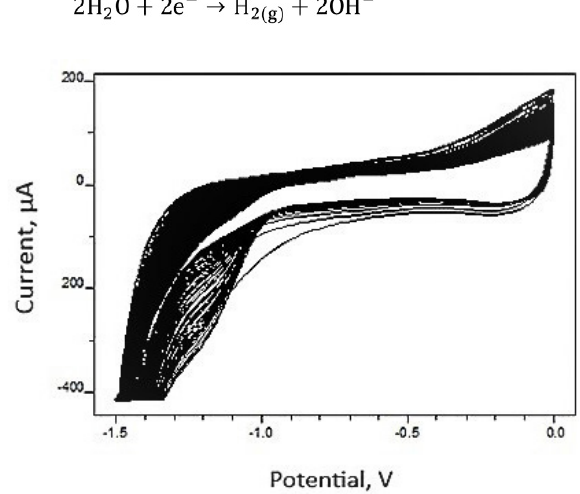
Figure 3. CV of electrochemical reduction of 1.0 mg mL −1 graphene oxide on GCE surface in acetate buffer solution (pH = 5) at the scan rate of 0.050 V s −1 in the potential range of (−1.2) – (2.2)